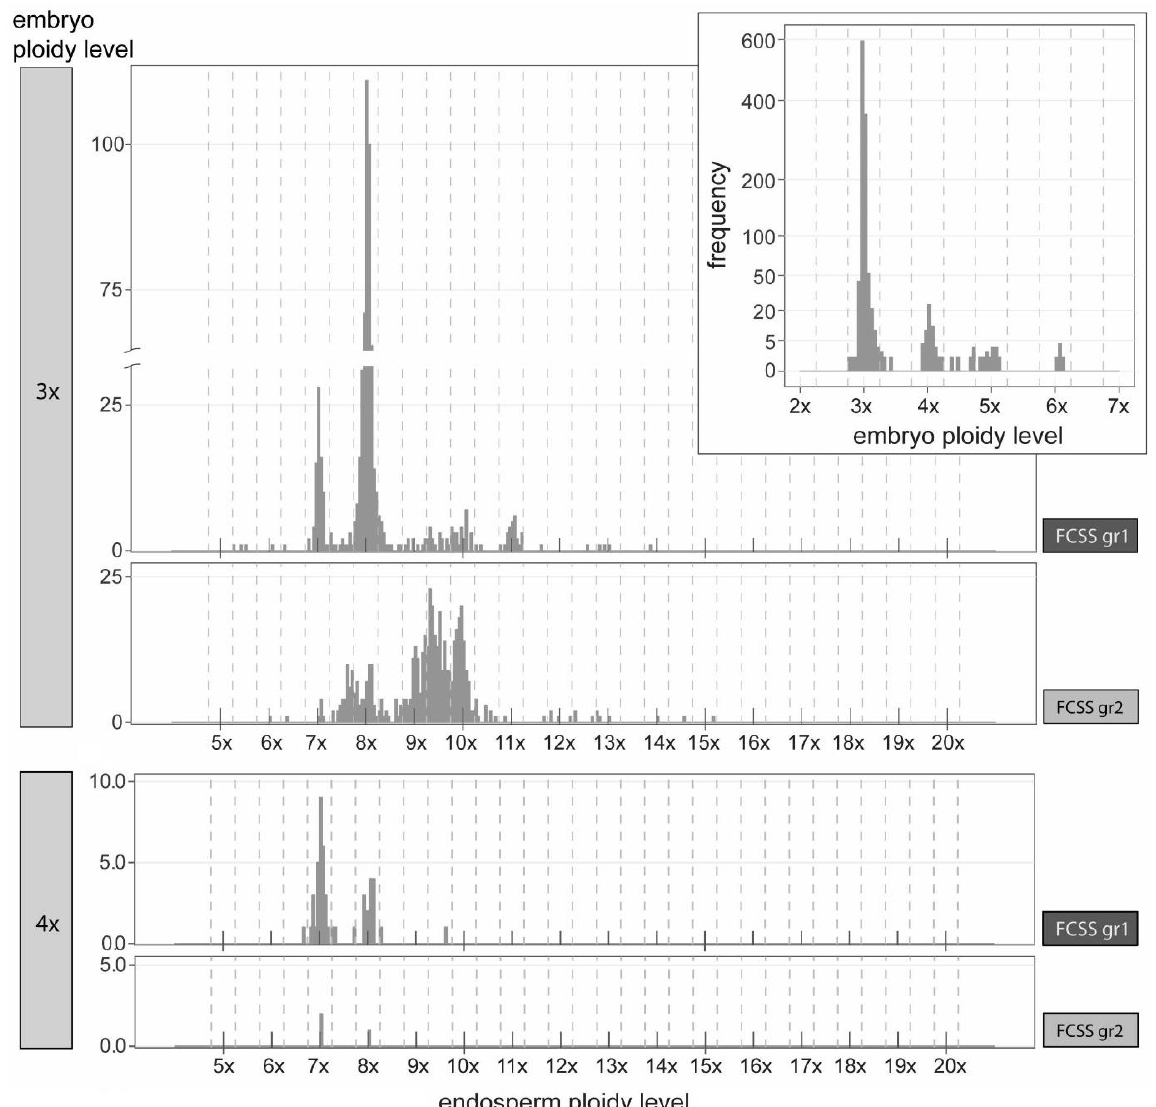
Figure 4. Calculated embryo (in inset) and endosperm ploidy levels from 20 triploid mother trees of Crataegus assigned to two FCSS groups, namely, FCSSgr1 and FCSSgr2, according to their reproduction pathways. The estimated euploid and aneuploid ploidy level categories are separated by vertical dashed lines. For simplicity, the endosperm ploidy level variation is shown only for the most abundant seed categories with 3x and 4x embryos.